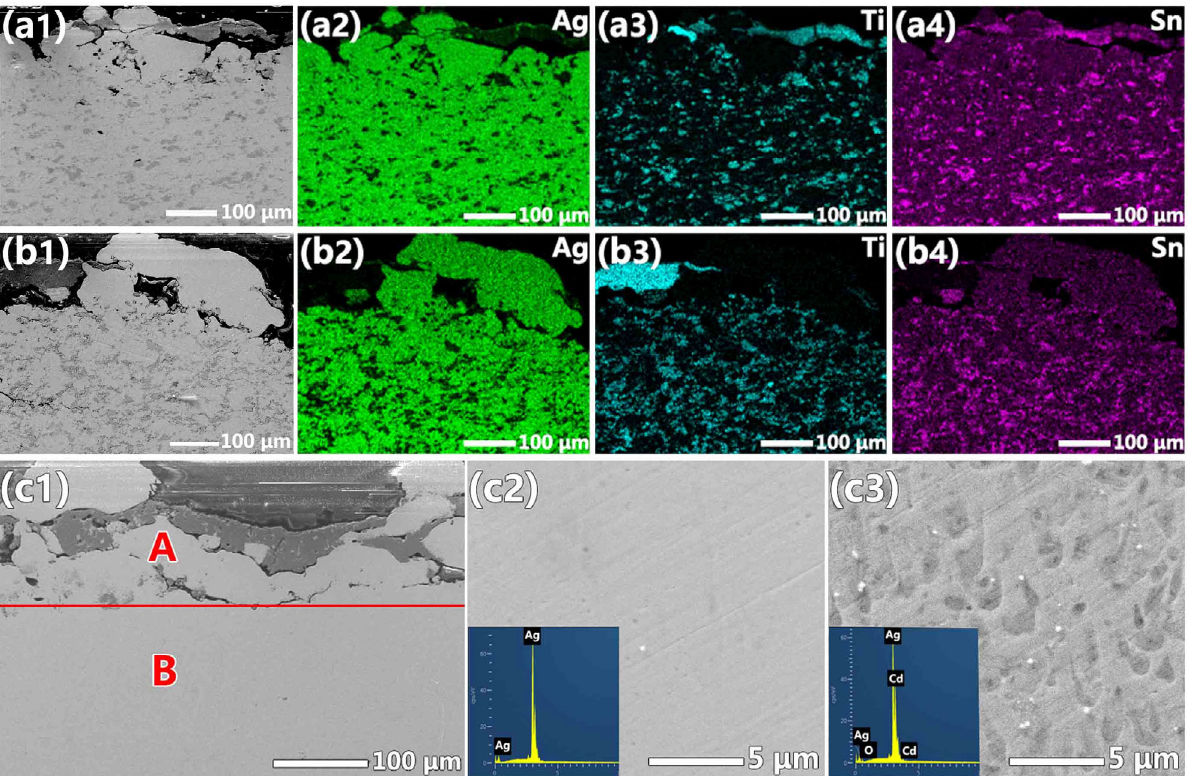
Fig. 10 Cross-sectional element dispersion of the erosion area in different contacts after electric arc discharging. (a1–a4) Ag/10TSC contact. (b1–b4) Ag/20TSC contact. (c1–c3) Ag/CdO contact. (c2) and (c3) show the amplified SEM images and the element composition of the area A and area B in (c1),